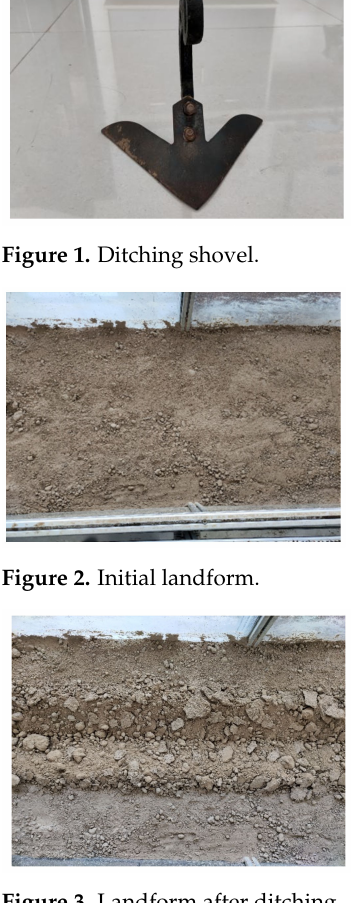
Figure 3. Landform after